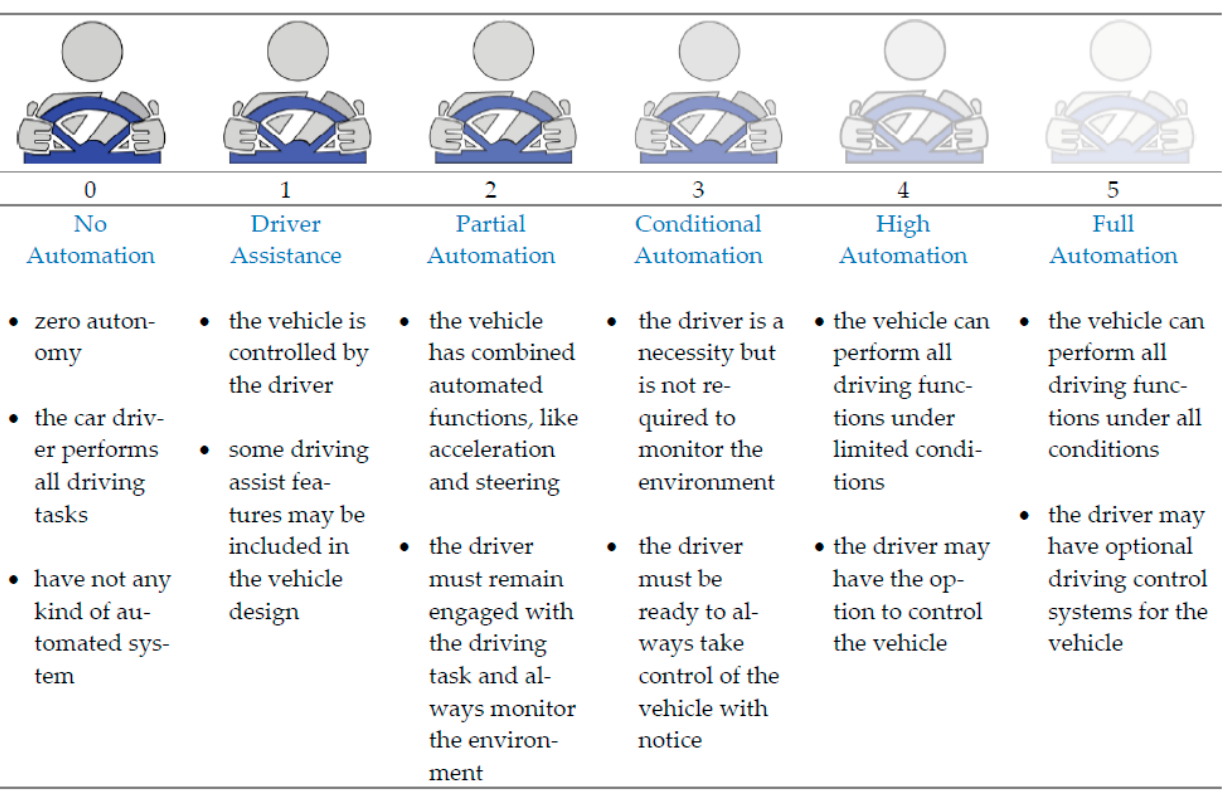
Figure 2. No automation to full automation levels and conditions of road vehicles where the zero level has no automation and the fi fth level has a full automation